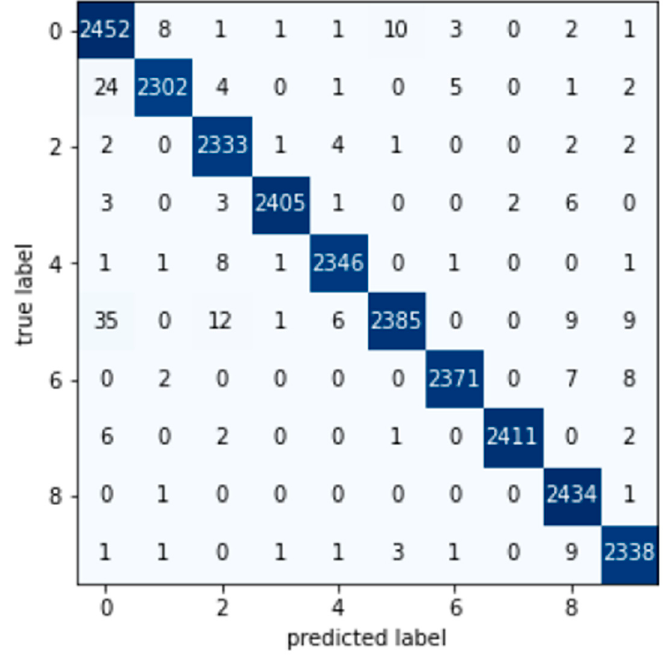
Figure 8. The confusion matrix of the CNN model. Table 8. Standalone deep-learning models trained on the MNIST Arabic digit dataset.